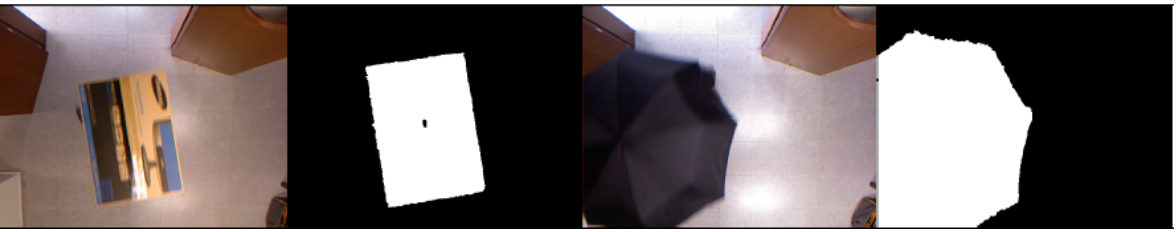
Figure 13. Two samples of selected situations with too large detected heads (left) and blob (right) size.